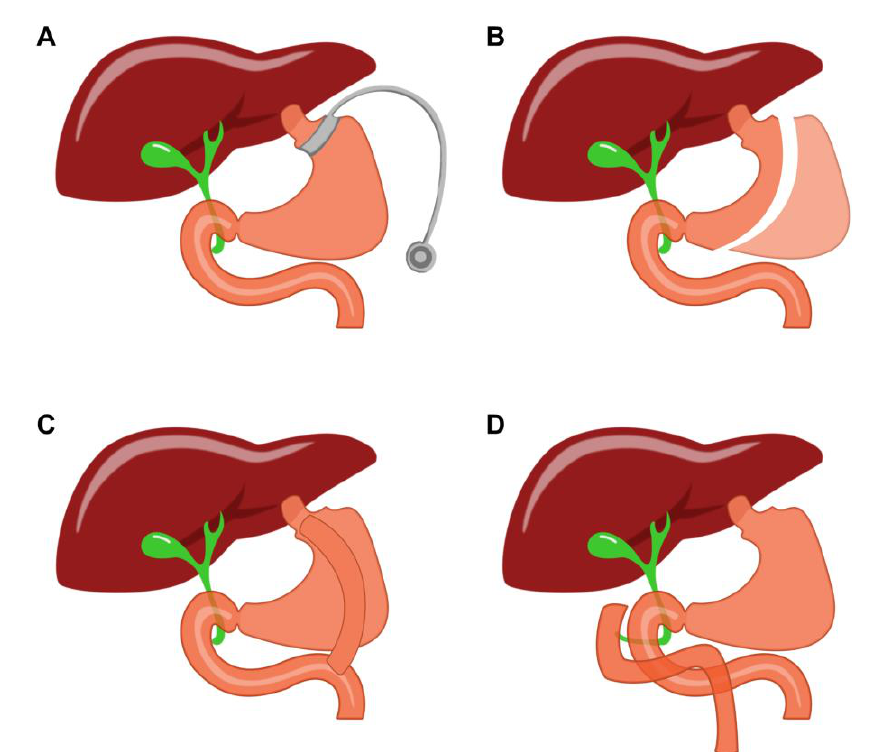
FIGURE 1: Contemporary proce- dures for metabolic surgery. (A) adjustable gastric banding (AGB); (B) vertical sleeve gastrectomy (VSG); (C) Roux-en-Y gastric bypass (RYGB); and (D) biliopancreatic diversion with duodenal switch